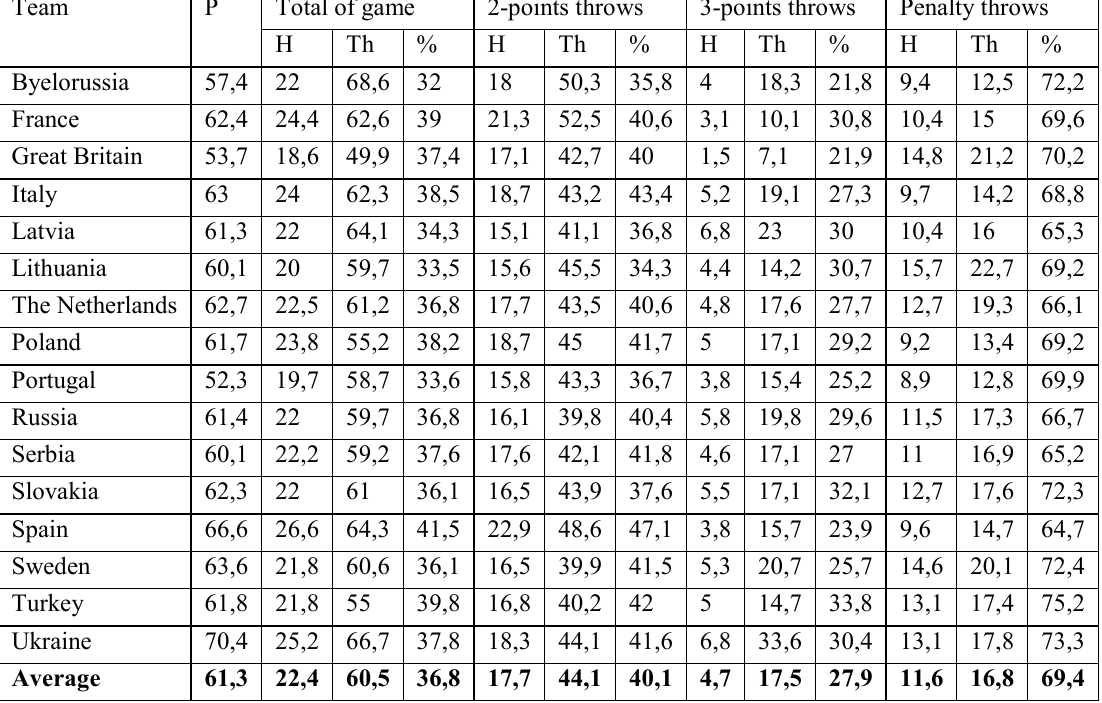
Effectiveness indicators of women’s teams under 20 at European Championship 2-points